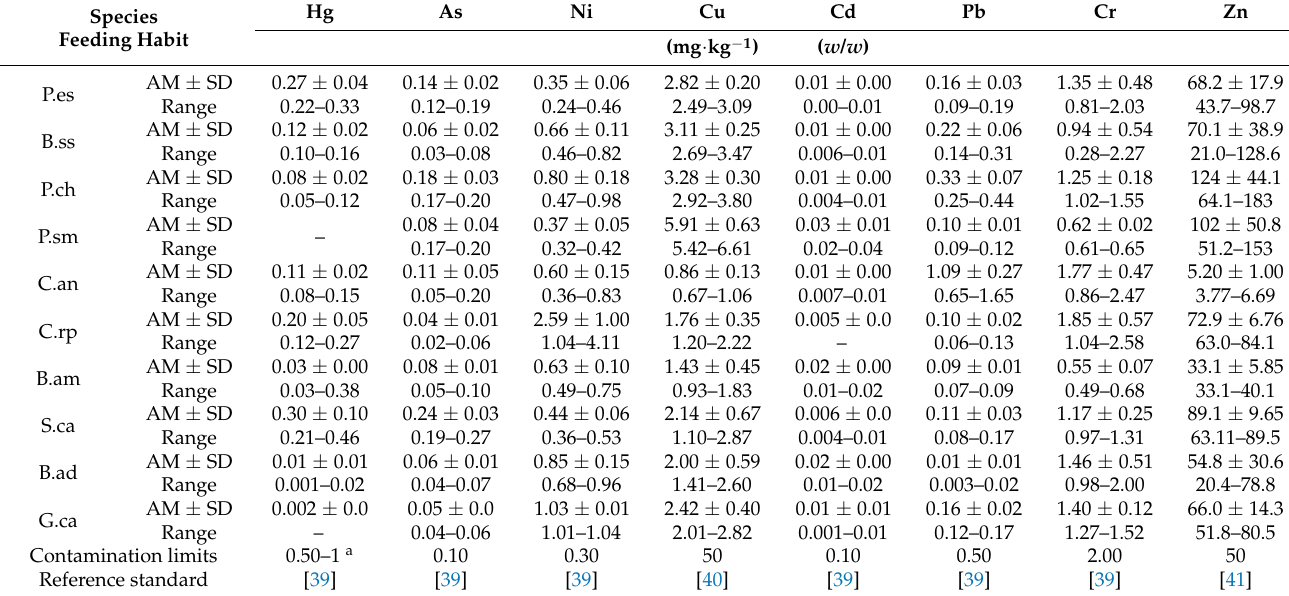
Table 2. Average content of trace metals in the back-muscle tissue different eating habits of fish. Species Feeding